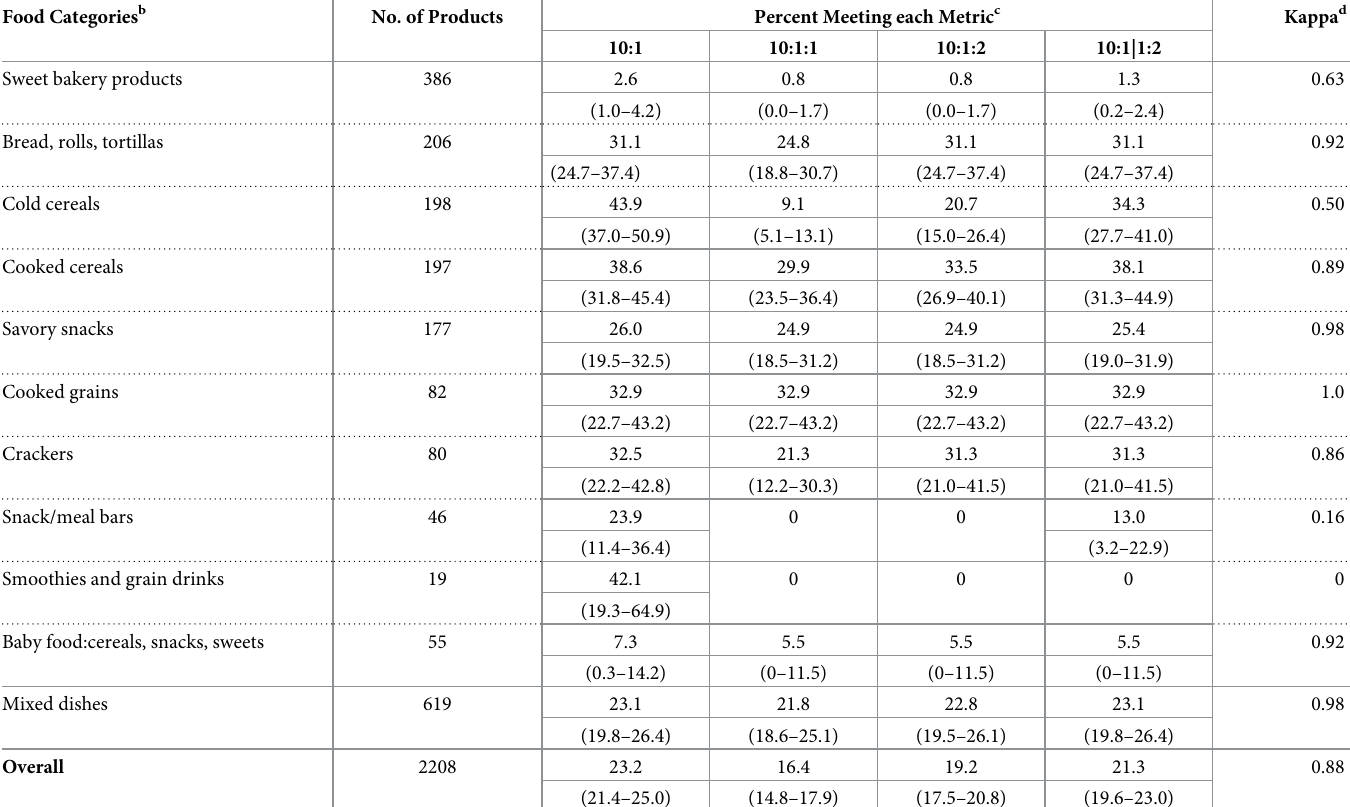
Table 1. Comparison of carbohydrate-rich products in the U.S. meeting each of four proposed metrics for assessing carbohydrate quality a . Food Categories b